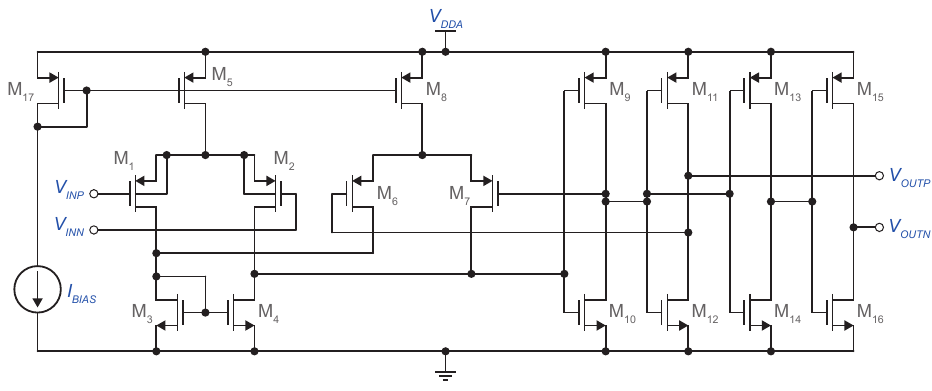
Figure 7. Comparator with hysteresis using an unbalanced differential